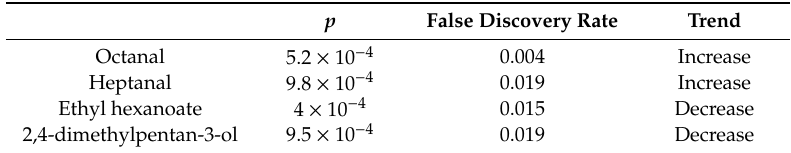
Table 2. Volatiles that changed significantly after iron treatment in Group 1.